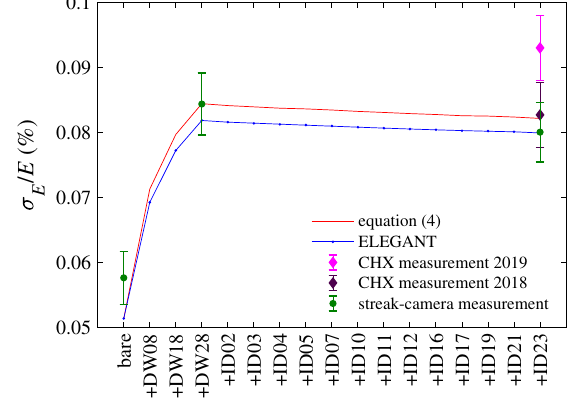
FIG. 7. Beam energy spread vs ID